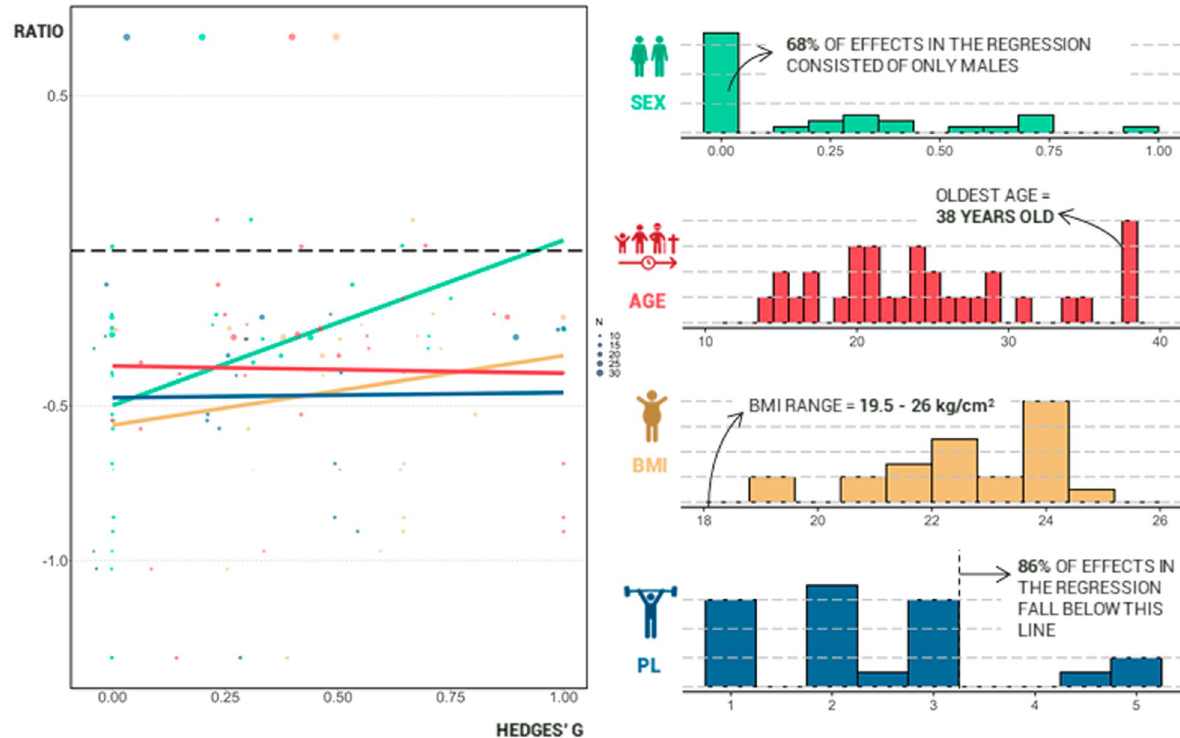
Fig. 7 Visual representation of the regressions and the overall distribution of the included individual features. Ratios were calculated for all features except for sex to portray all equations in the same graph (ratio feature minimal value of that feature). Sex ratio was calculated by dividing the total number of women by the total number of −